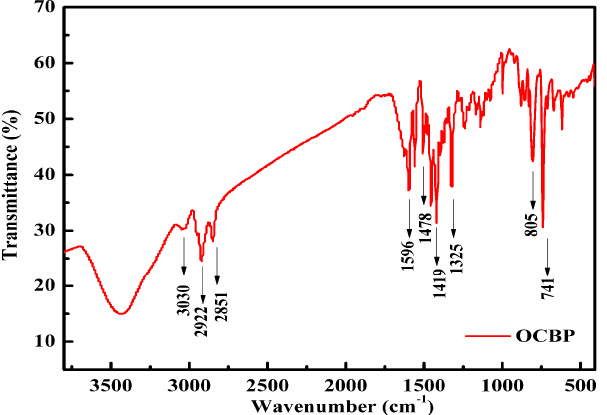
Figure 12. IR spectrum of OCBP.